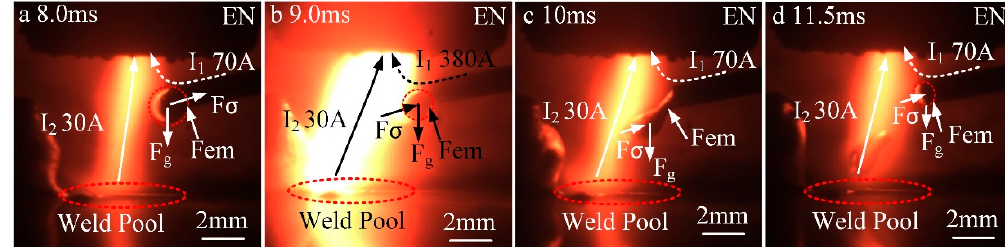
Figure 7. Analysis of forces acting on the anode droplet during the falling stage. ( a ) 8.0 ms, ( b ) 9.0 ms, ( c ) 10 ms and ( d ) 11.5 ms.